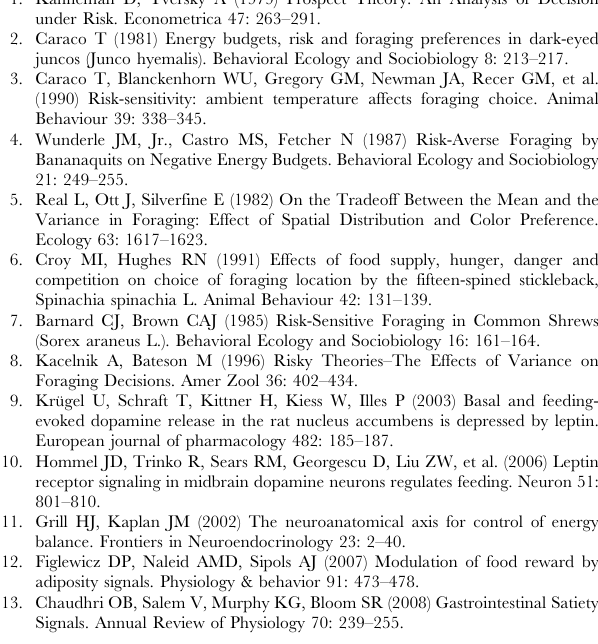
Table S1 Baseline anthropometric and glucose results for included subjects.